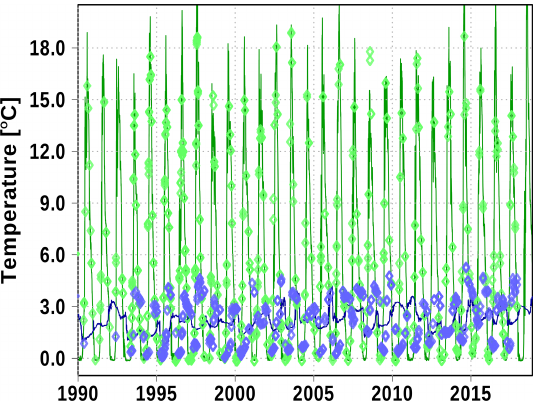
Figure A4. Surface (green) and bottom (blue) temperature at station F9. Solid line: model; diamonds: observations (http://www.ices.dk, last